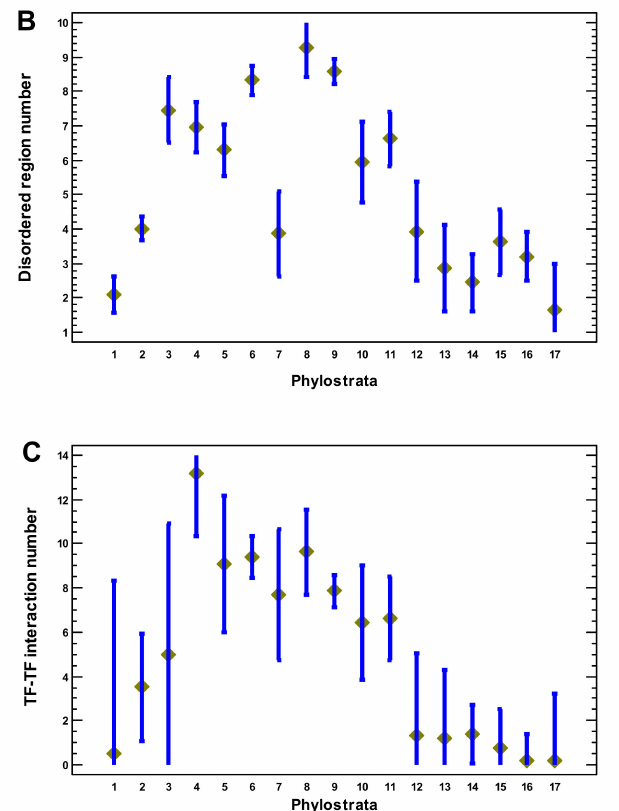
Figure 8. Phylostratic course of complexity-related gene properties. ( A ) Number of GO bio- logical processes in which a gene participates. ( B ) Number of disordered regions in a protein. ( C ) Number of TF–TF interactions. Means with LSD intervals ( p < 0.05). (1—cellular organisms;